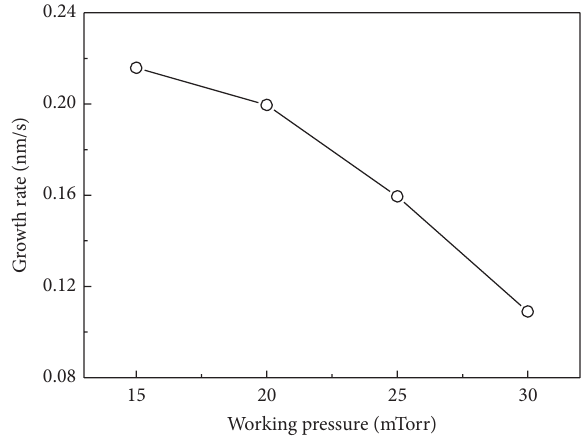
Figure 3: The growth rate as a function of working